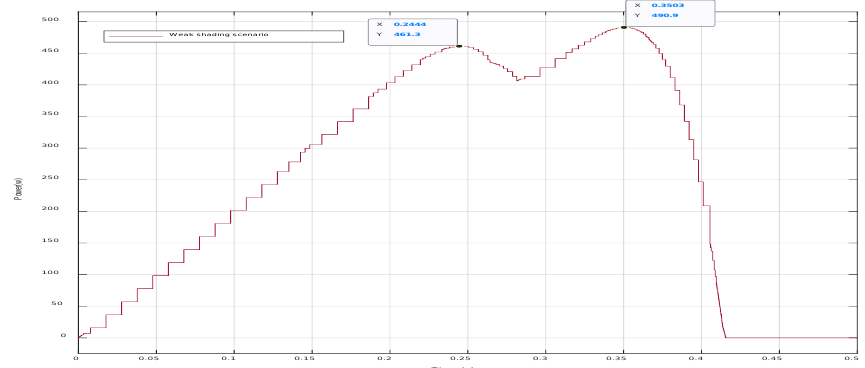
Figure 7. Scenario of Case One (Weak shading pattern).